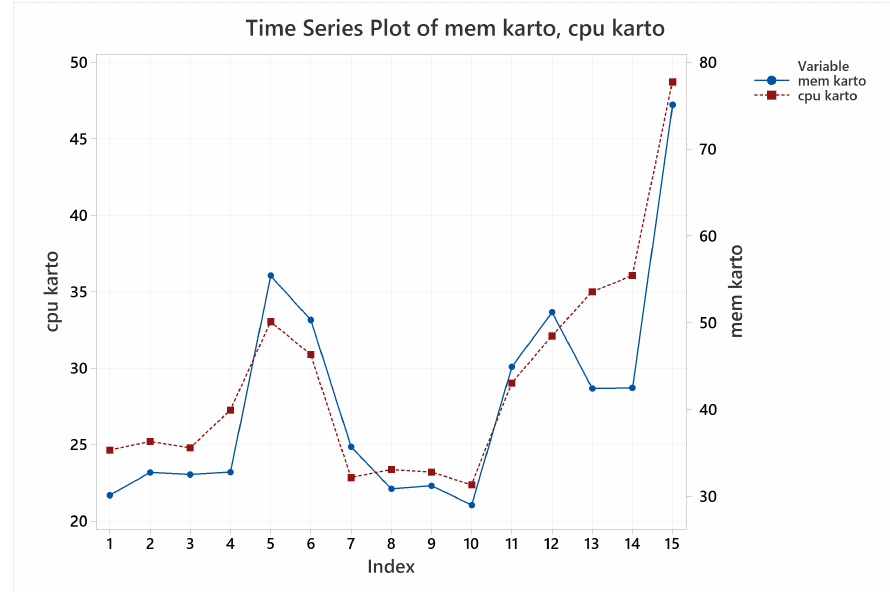
Figure 25. CPU and memory usage behavior for KARTO-SLAM on all the runs.